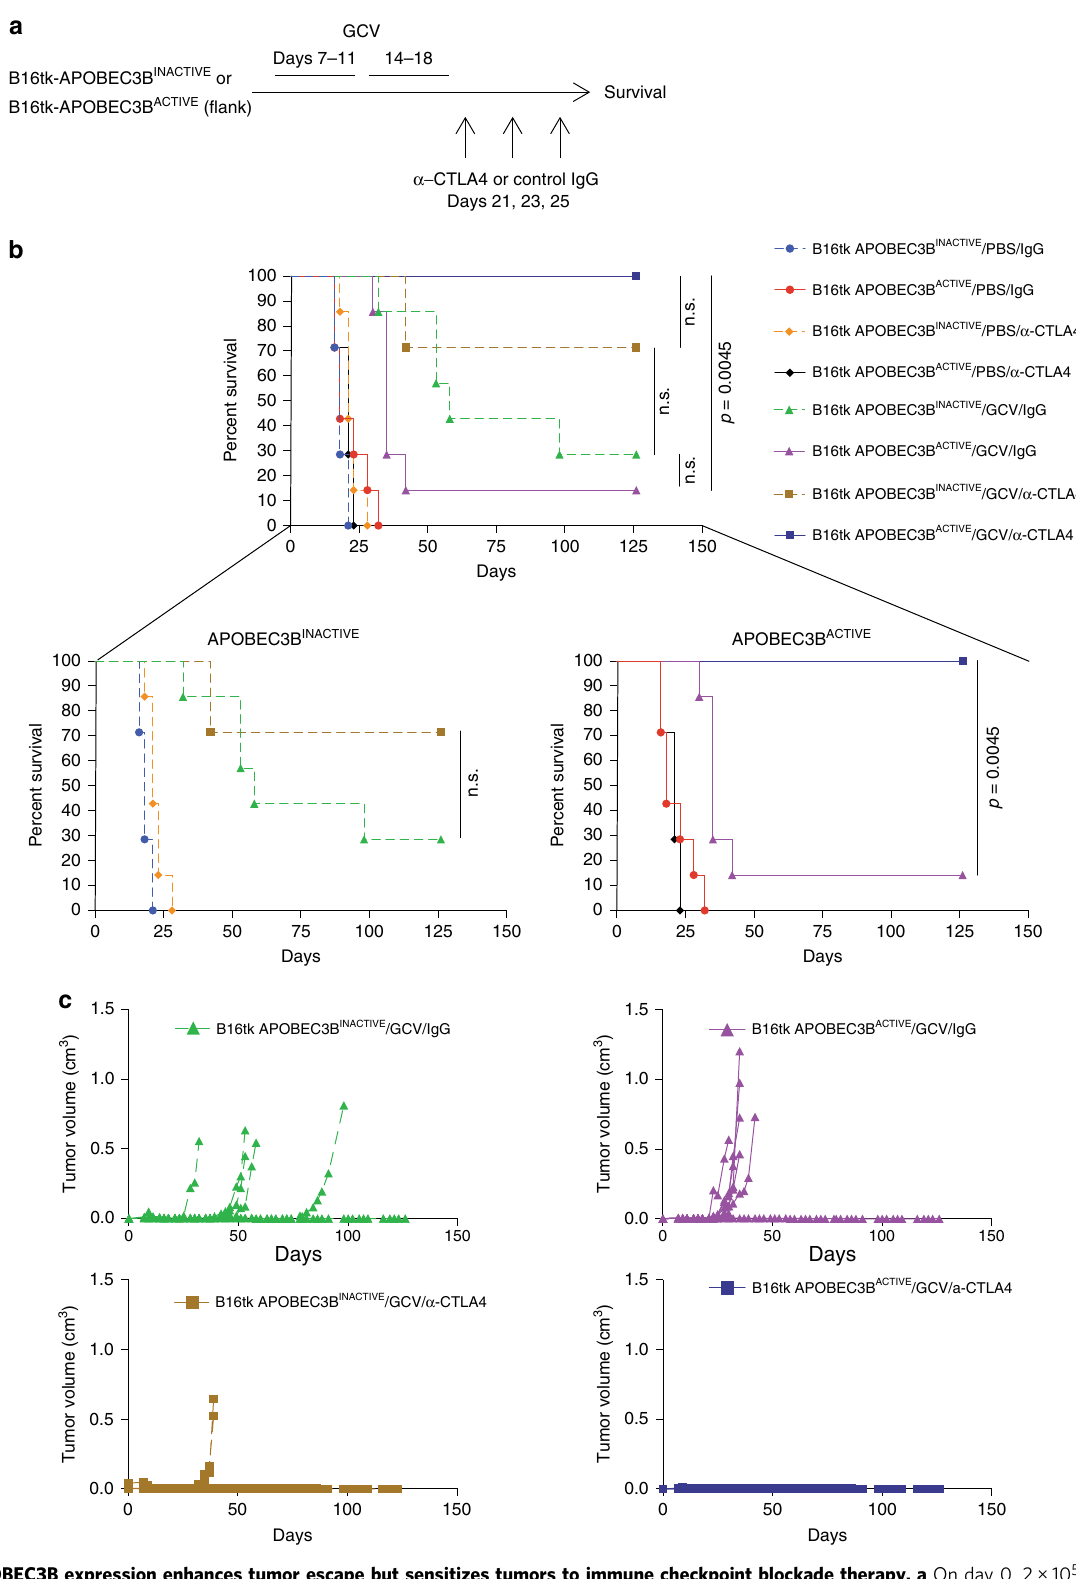
Fig. 1 APOBEC3B expression enhances tumor escape but sensitizes tumors to immune checkpoint blockade therapy. a On day 0, 2 × 10 5 B16TK cells expressing either APOBEC3B INACTIVE or APOBEC3B ACTIVE were subcutaneously implanted into the right fl ank of C57Bl/6 mice. Two 5-day courses of GCV therapy (50 mg/kg i.p.) were administered from days 7 to 11, and 14 to 18, followed by anti-CTLA4 antibody or control IgG (5 mg/kg i.p.) on days 21, 23, and 25. b , c Mice were treated according to the regimen in ( a ) ( n = 7 mice/group) tumor volumes were measured three times per week ( c ) and sacri fi ced when tumors grew above 1 cm in length or width. Representative of three separate experiments. Groups were compared using a Log-Rank test with Holm – Bonferroni correction for multiple